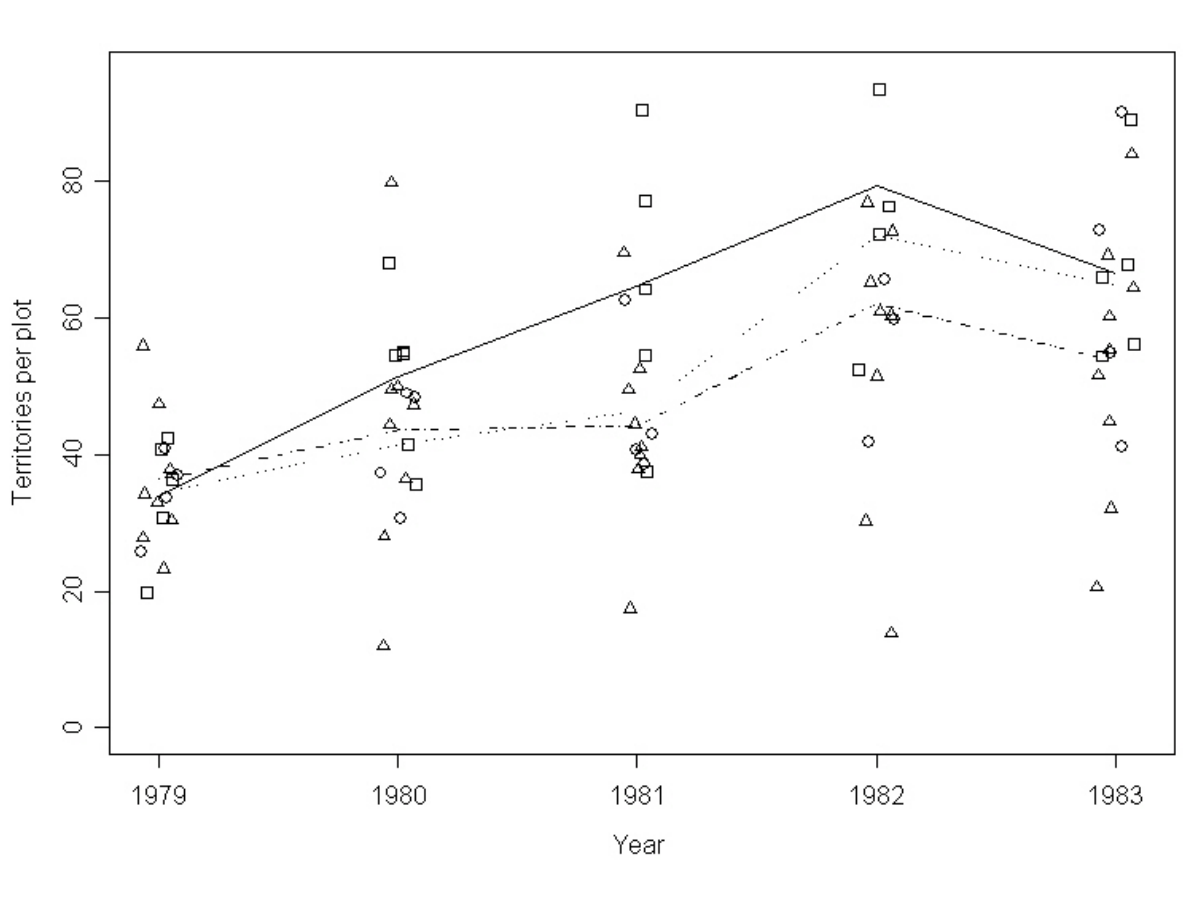
Fig. 3 . Number of bird territories in each plot in young (triangle), intermediate (circle), and mature (square) stand-age classes. Lines indicate the mean in mature plots (solid), intermediate plots (dotted), and young plots